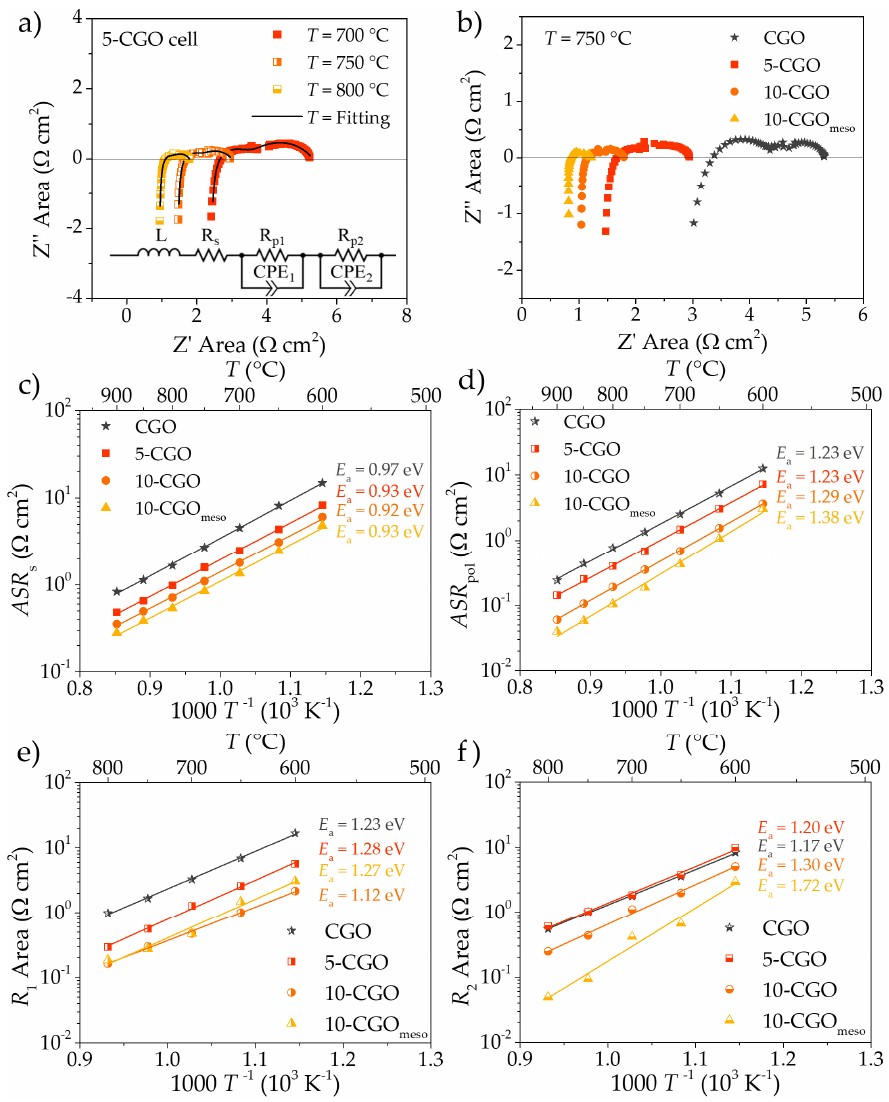
Figure 6. EIS spectra of the 5-CGO cell at 700, 750 and 800 °C. ( a ) The equivalent circuit used for the ( b ) EIS spectra of the four cells (CGO, 5-CGO, 10-CGO and 10-CGO meso ) at 750 °C. ( c ) Serial ASR